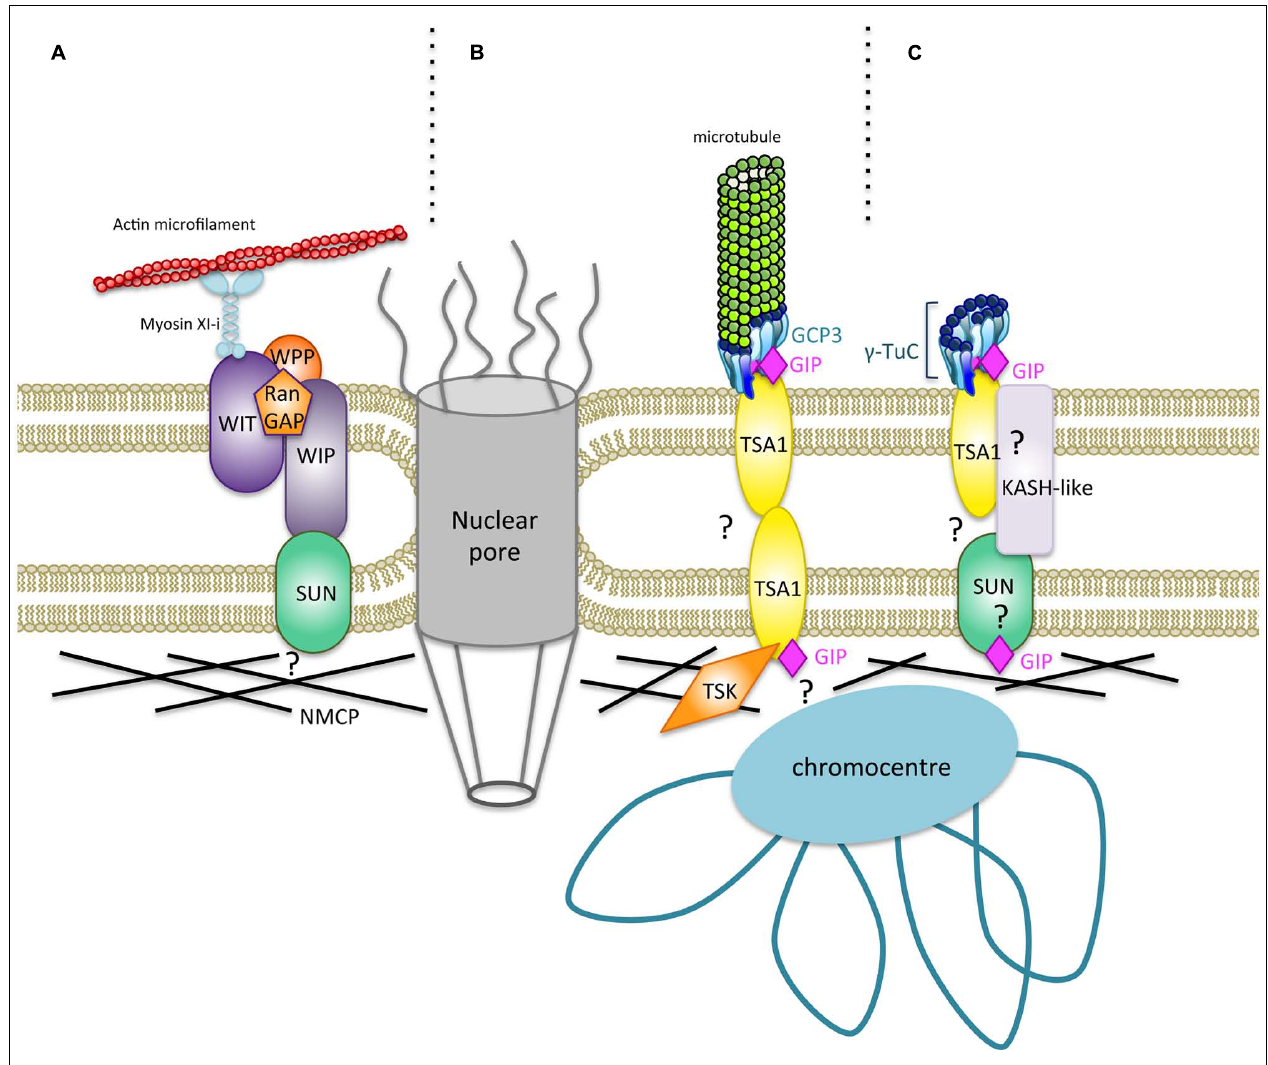
TSA1, a putative transmembrane protein. TSK localizes in the nucleoplasm (Suzuki etal., 2004; Takeda etal., 2004; Ohno etal., 2011) and may